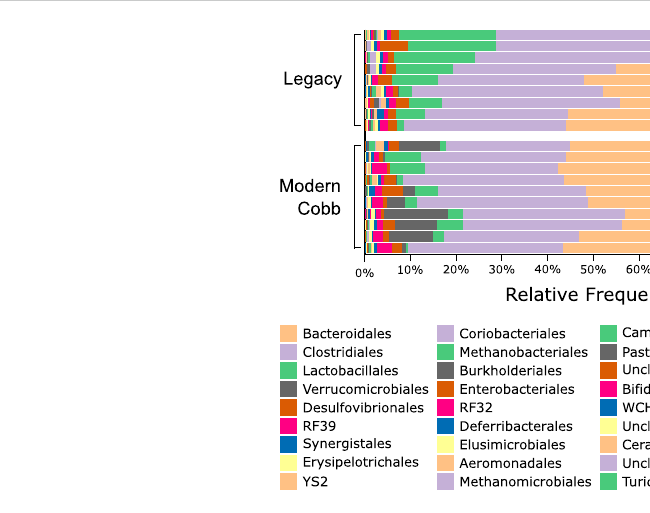
FIGURE 4 Taxonomic composition of Legacy line and Cobb line Cecal microbiome at the Order level.